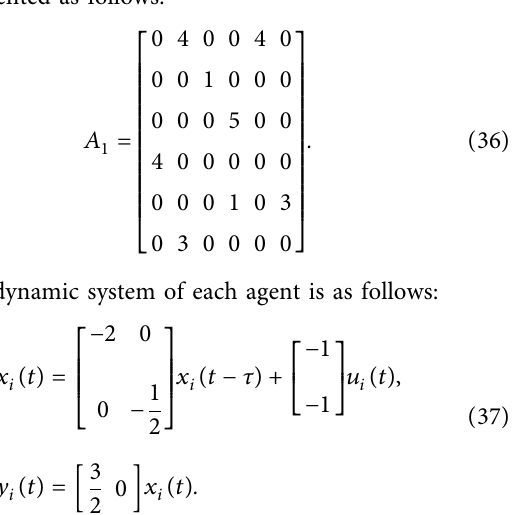
( t ) with τ � 0 . 3. i 1